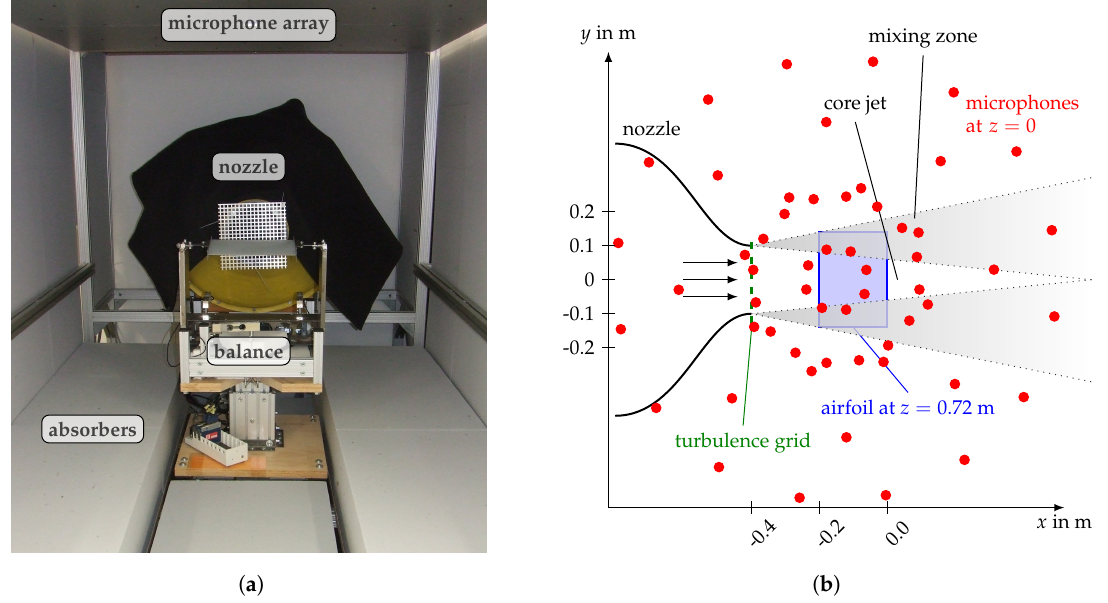
Figure 1. ( a ) Photograph (taken from downstream direction) and ( b ) schematic (top view) of the measurement setup inside the aeroacoustic wind tunnel